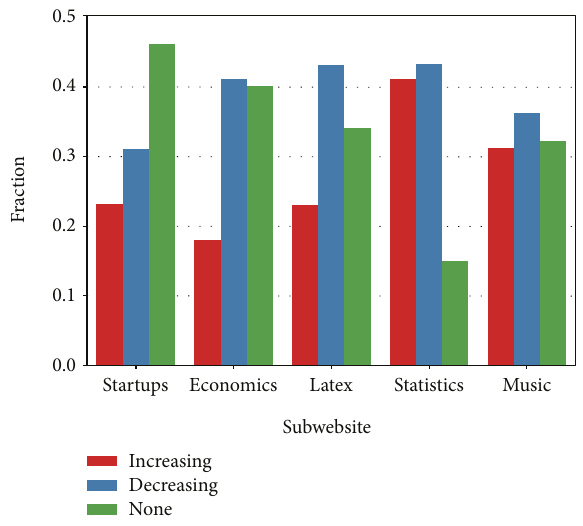
Figure 7: The coreness monotonicity of all cascade paths extracted from all cascade trees originating from the cascade initiators. On the x -axis, the di ff erent subwebsites are shown and on the y -axis, the fraction of paths is monotonically increasing, monotonically decreasing, or none